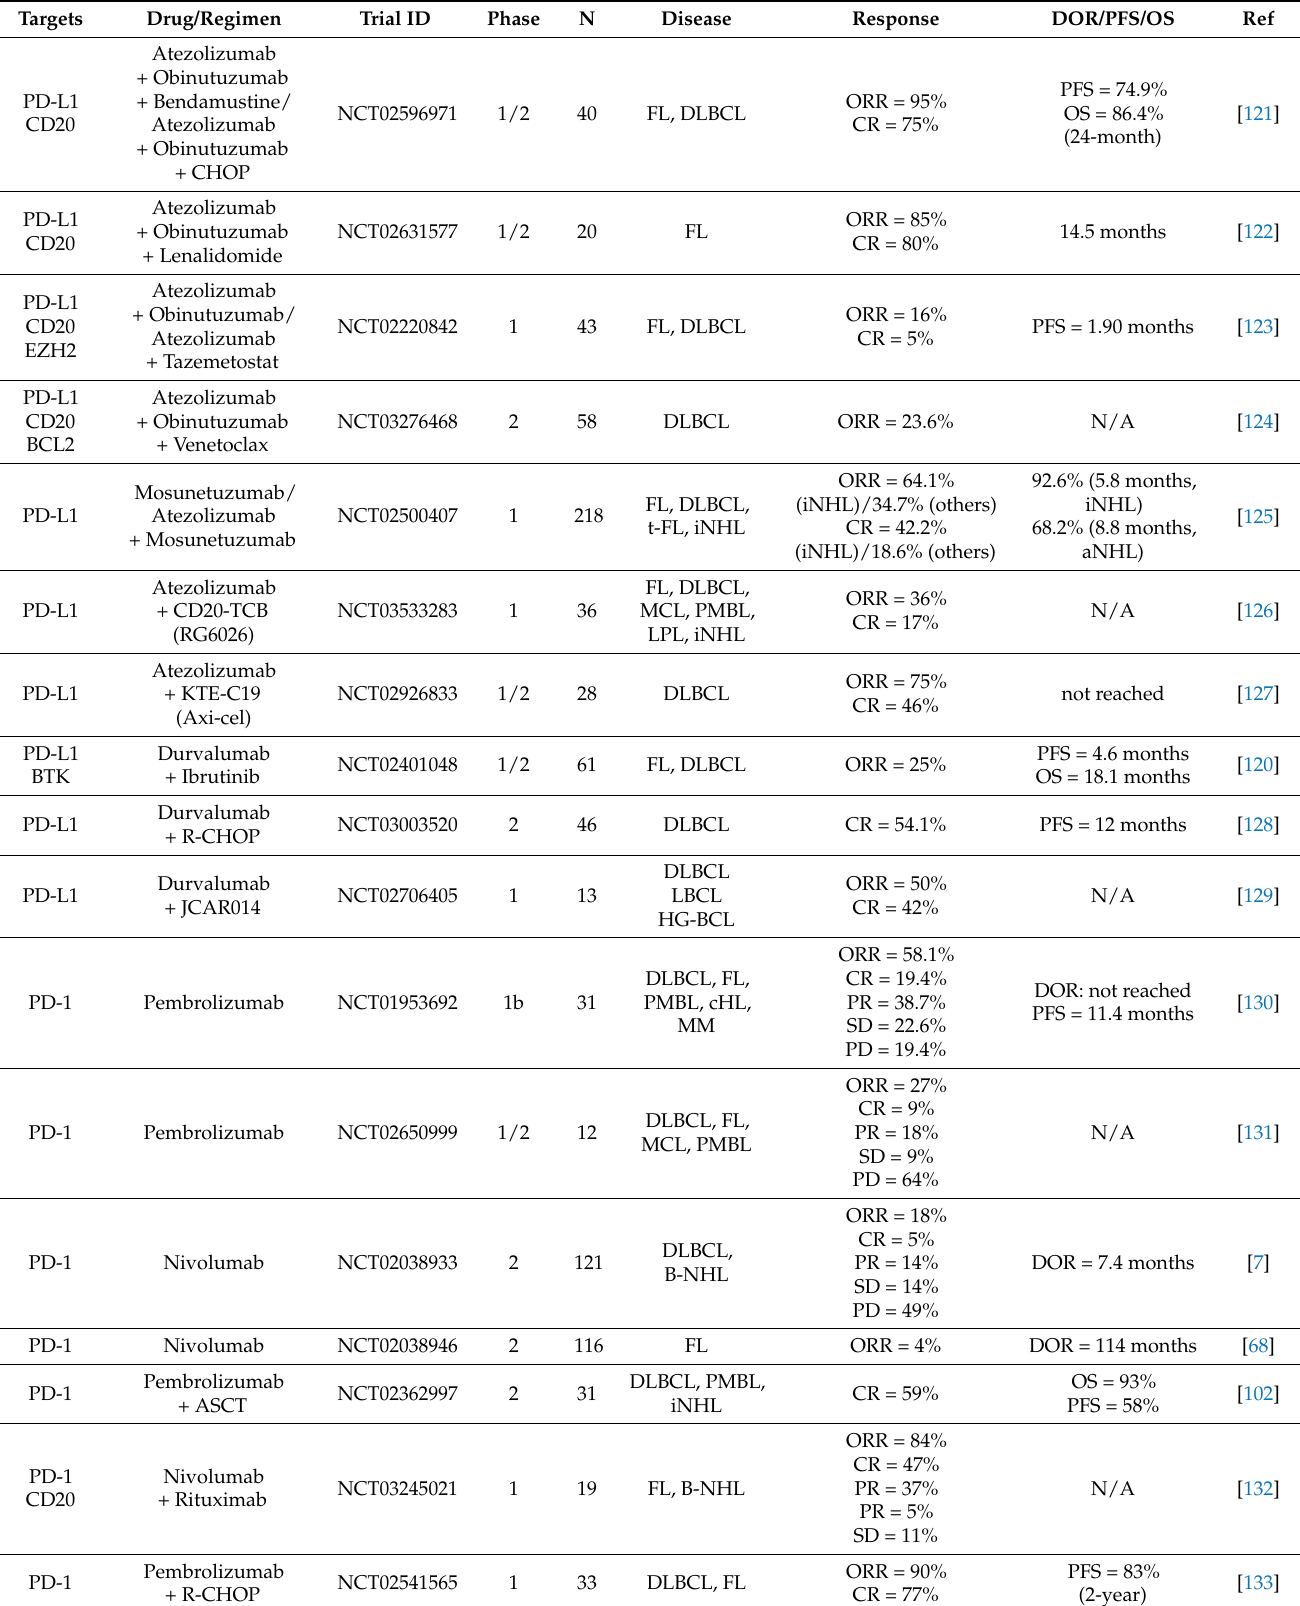
Table 1. Clinical evaluation of immune checkpoint-based therapies blockade for the treatment of B-cell lymphomas.